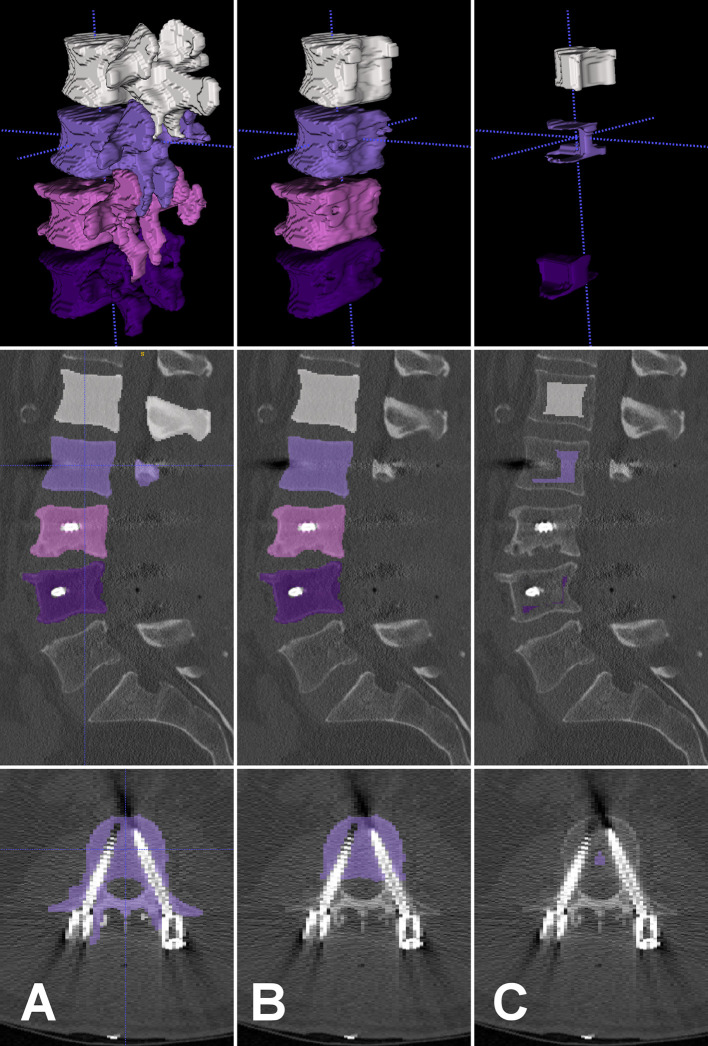
Top to bottom row: Segmentation masks in 3D-rendering, in sagittal view, and in axial view overlaid on postoperative CT scan. Left to right columns: Automatically created segmentation masks of L1 to L4 excluded screw contours by HU thresholding (A). Posterior elements were removed from segmentation masks (B). The outer 10 mm were eroded from segmentation mask and L3 mask was removed due to degenerative changes (C). These final segmentation masks served as ROIs to extract HU from the CT scan for opportunistic BMD screening. HU, Hounsfield units; BMD, bone mineral density; ROI, region of interest.